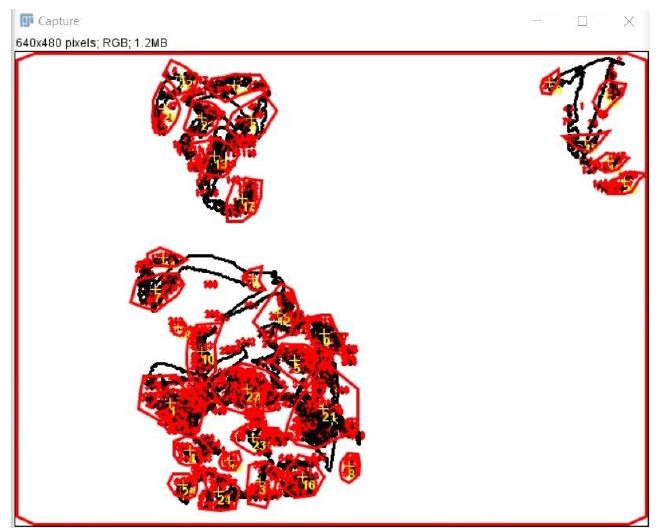
Figure 12. Nb particles analyzed as an ROI on Fiji software and processing by a segmentation al- gorithm.